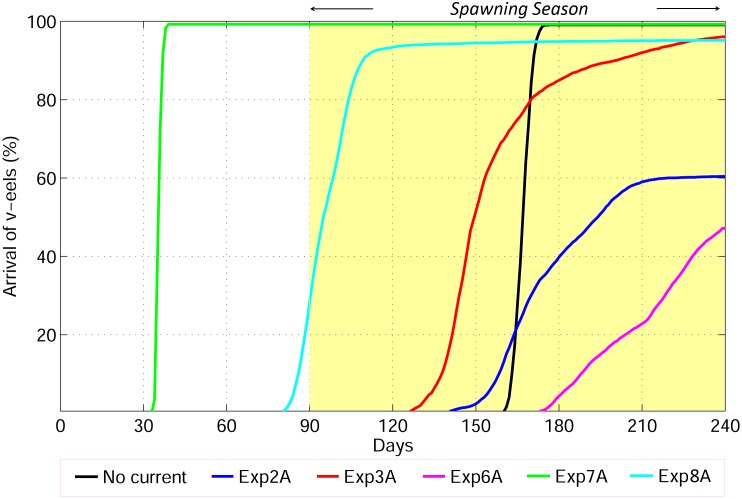
Percentage of v-eels arriving at the spawning area over time in Exp. 2A (compass orientation 0.15 m s−1), Exp. 3A (true navigation, 0.15 m s−1), Exp. 6A (0.1 m s−1), Exp. 7A (0.65 m s−1), and Exp. 8A (0.65 m s−1 against the Kuroshio).The yellow area marks the spawning period.